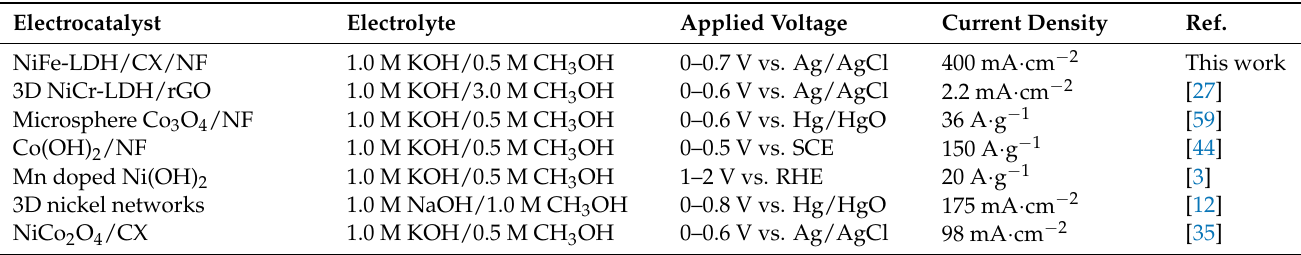
Table 3. Comparison of current densities, electrolyte, and applied potential with several reported electrocatalysts for methanol oxidation. Electrocatalyst Electrolyte Applied Voltage Current